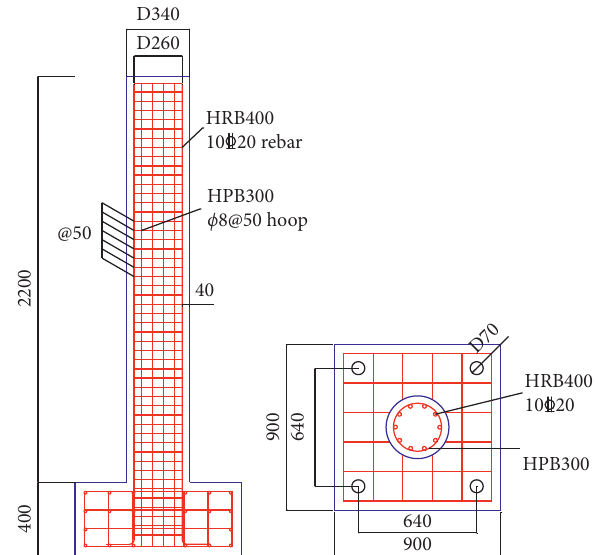
Figure 1: Schematic diagram of the specimen (dimension unit: